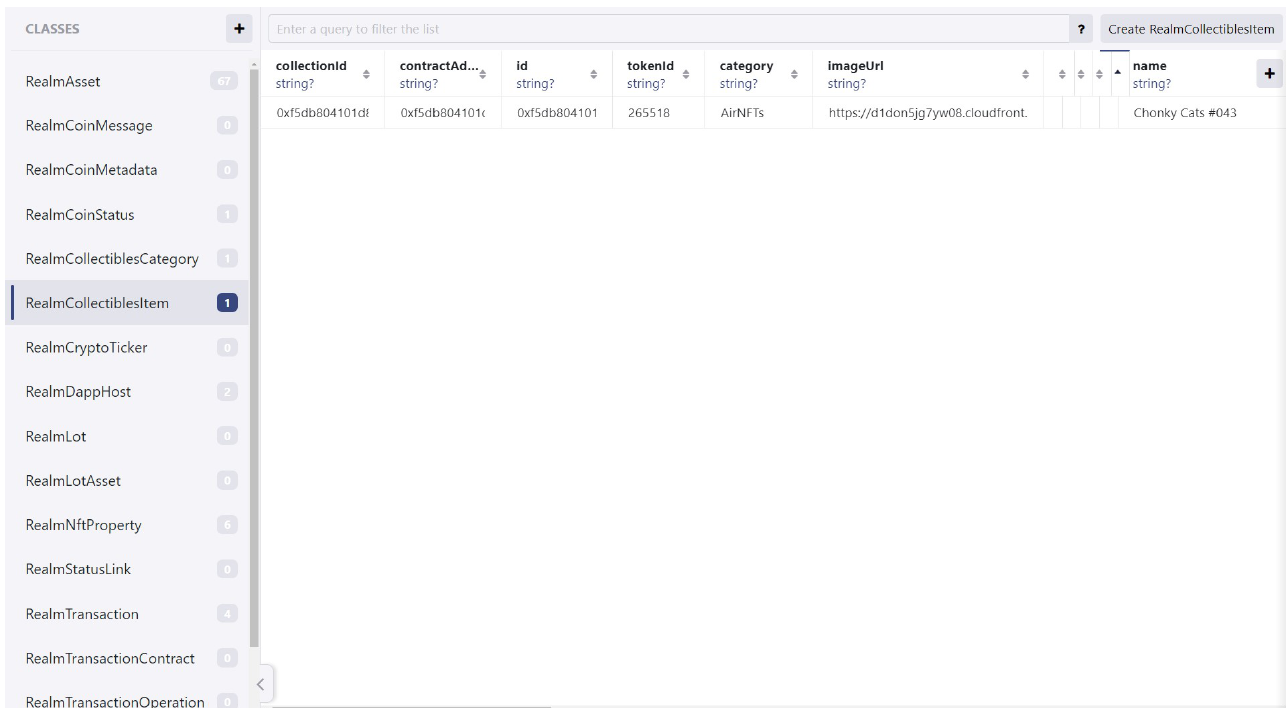
Figure 35. Wallet m-2-1653501108488 Realm database opened using Realm Studio software.